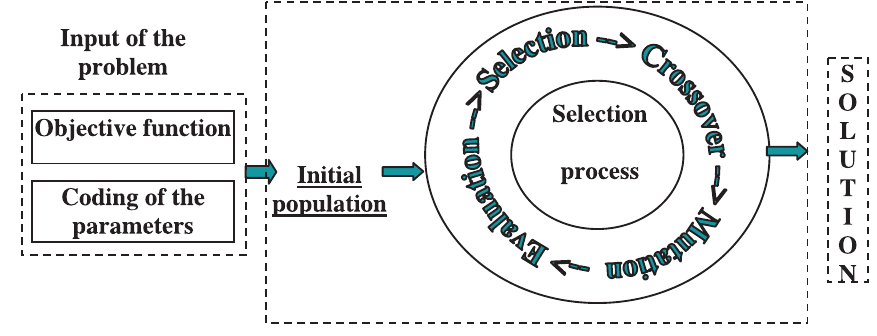
Fig. 5. Principle of a genetic